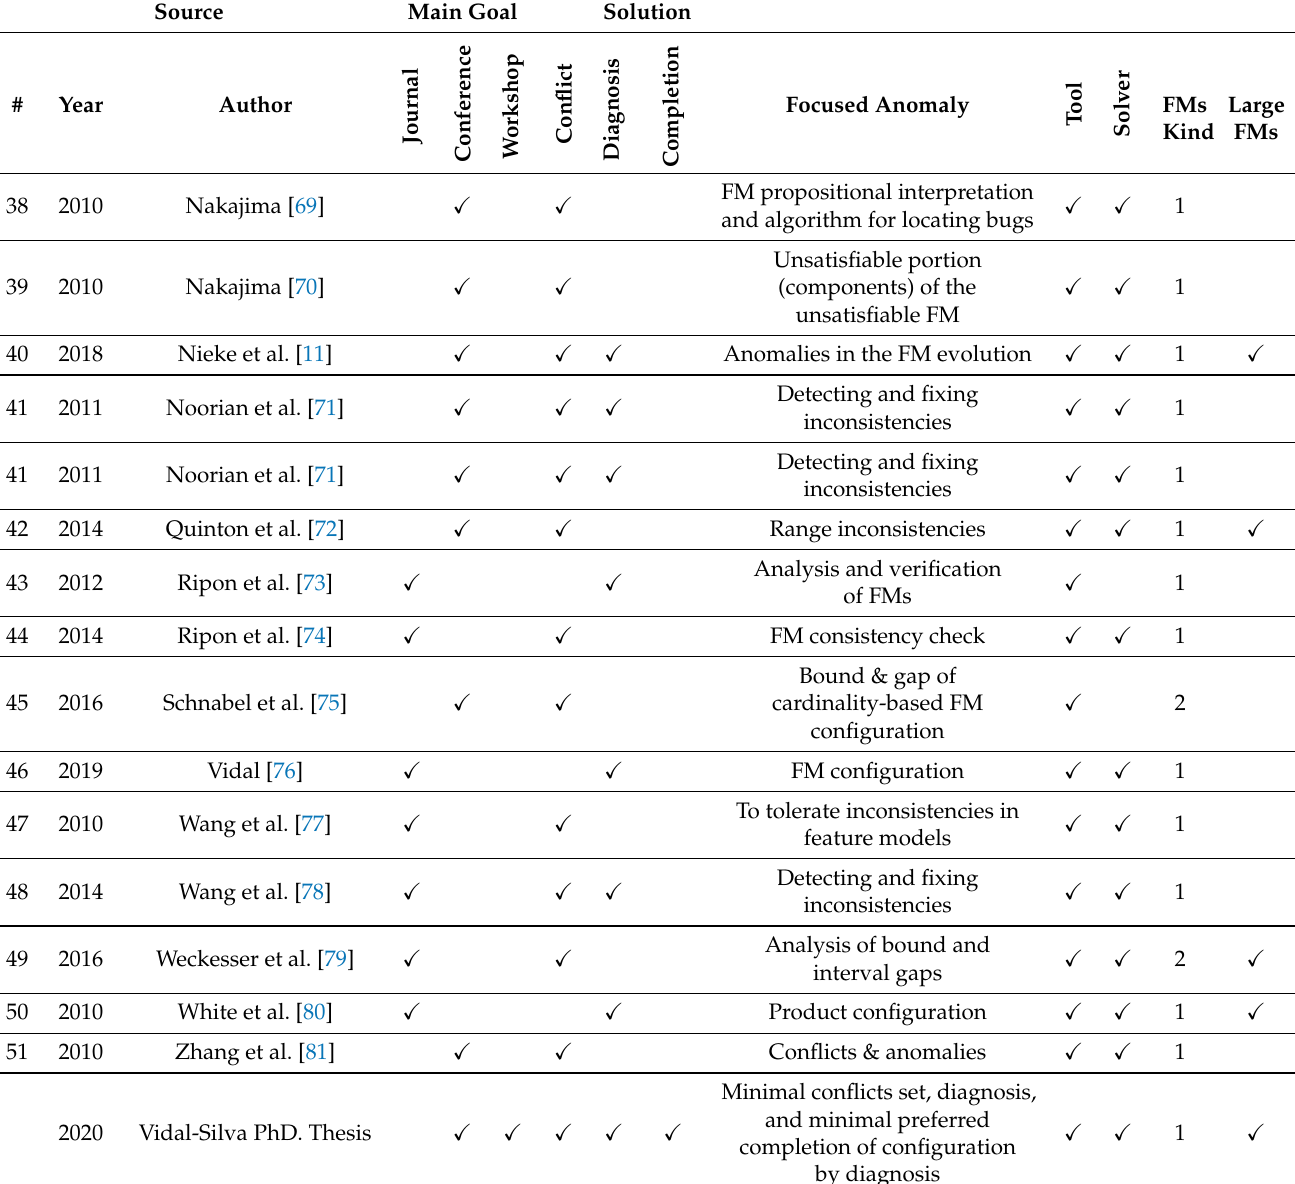
Table 4. List of articles ordered by the authors’ last name from N to Z in the SLR vs. our thesis work. Source